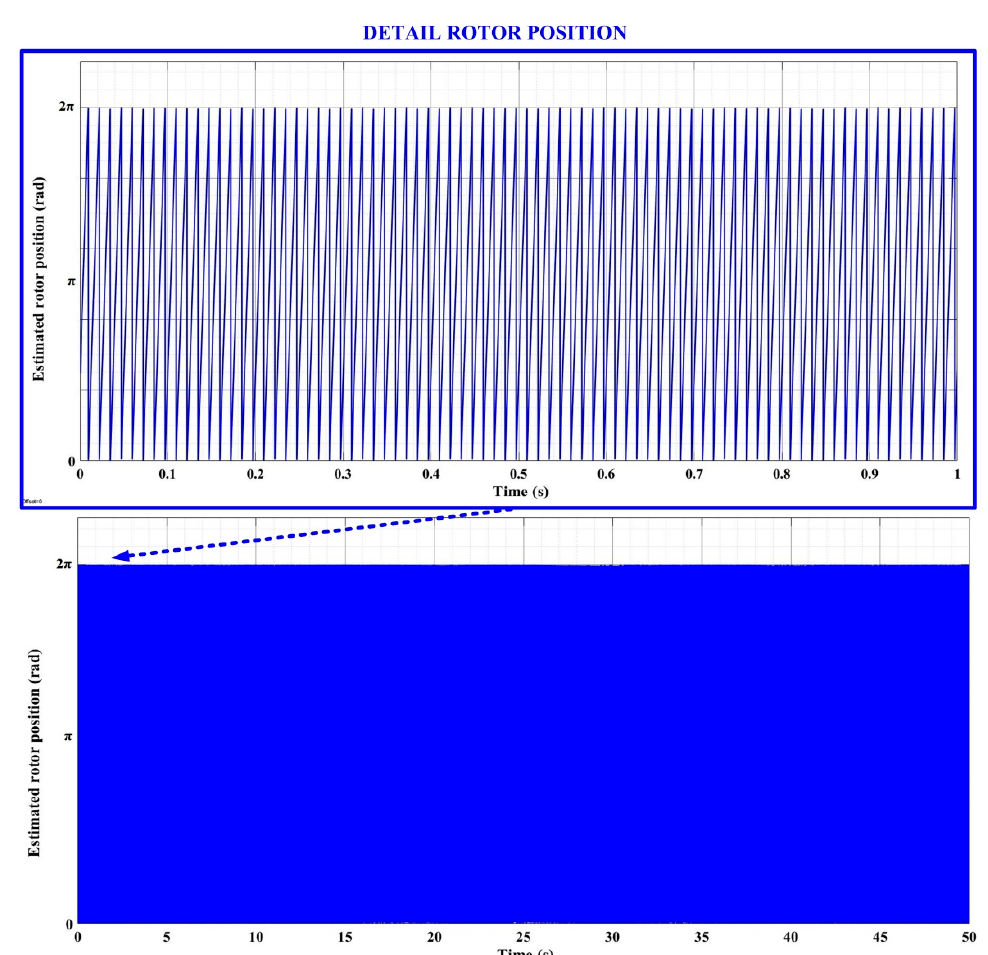
Figure 36. Real-time evolution for the estimated PMSM rotor speed—HIL stage; T L = 1 Nm.